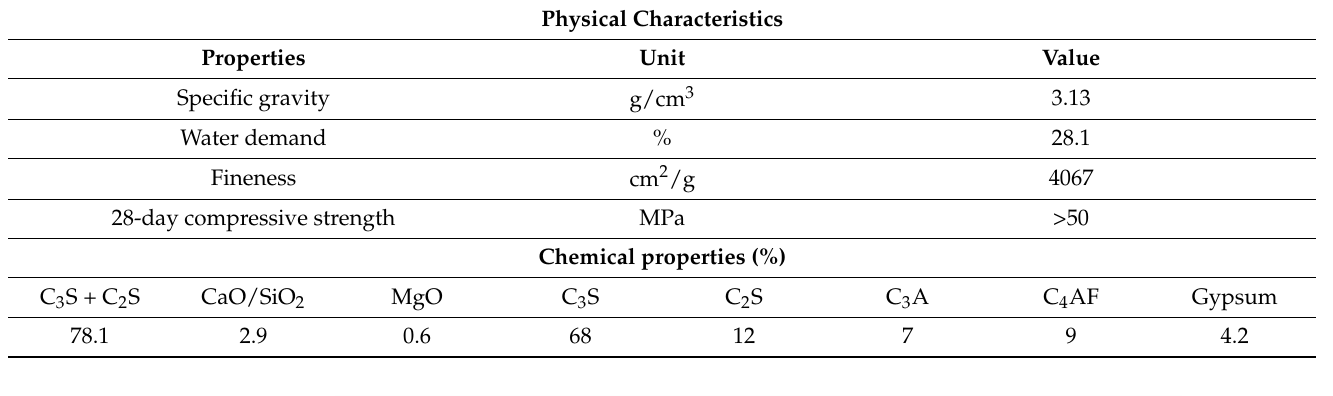
Table 1. Physical characteristics and chemical properties of Portland cement (CEM I 52.5R).